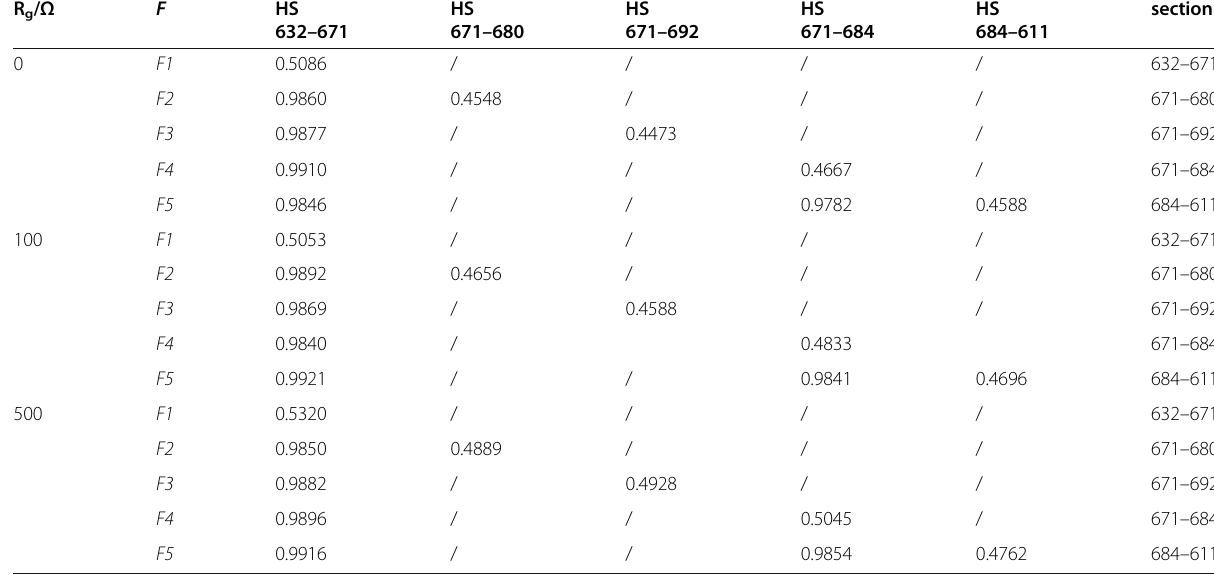
Table 11 Results of the matching degree method in the IEEE 13-node system ( φ = 0 ∘ ) R g /